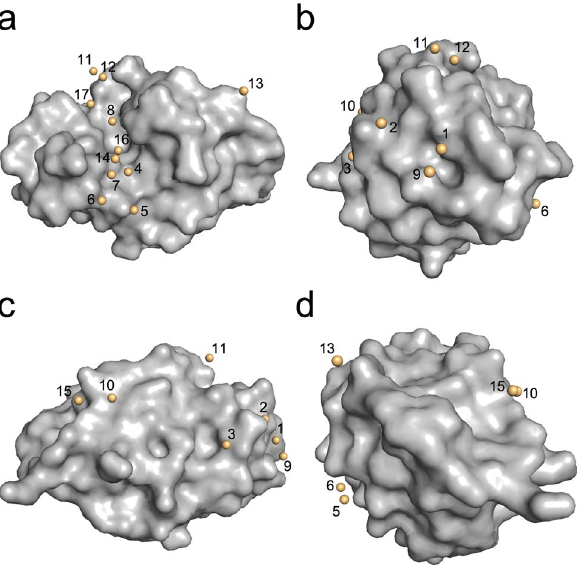
Figure 3. Overview of all observed cesium sites in HEWL. Numbering is coherent with Table 5. HEWL is represented as surface, cesium ions as spheres. ( a ) Front view. ( b ) Side view left. ( c ) Back view. ( d ) Side view